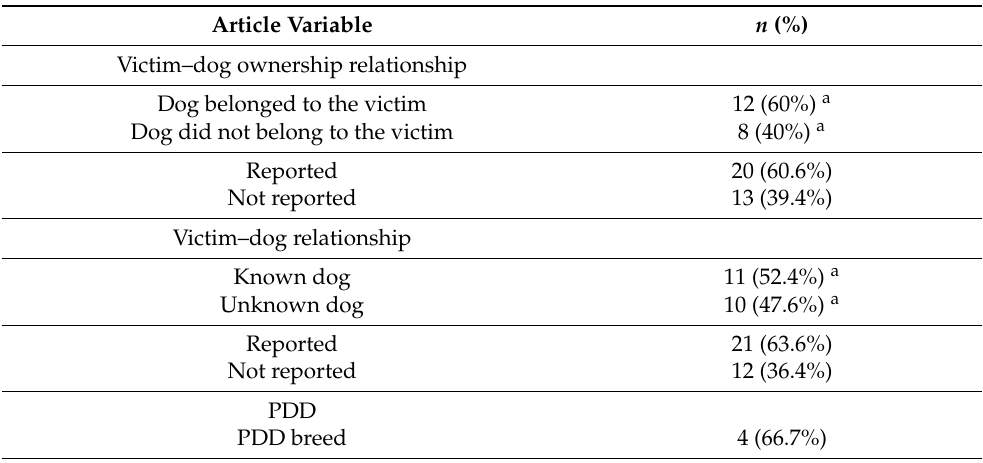
Table 6. Information on the biting dog and its relationship with the victim, collected from 33 articles on dog bites resulting in